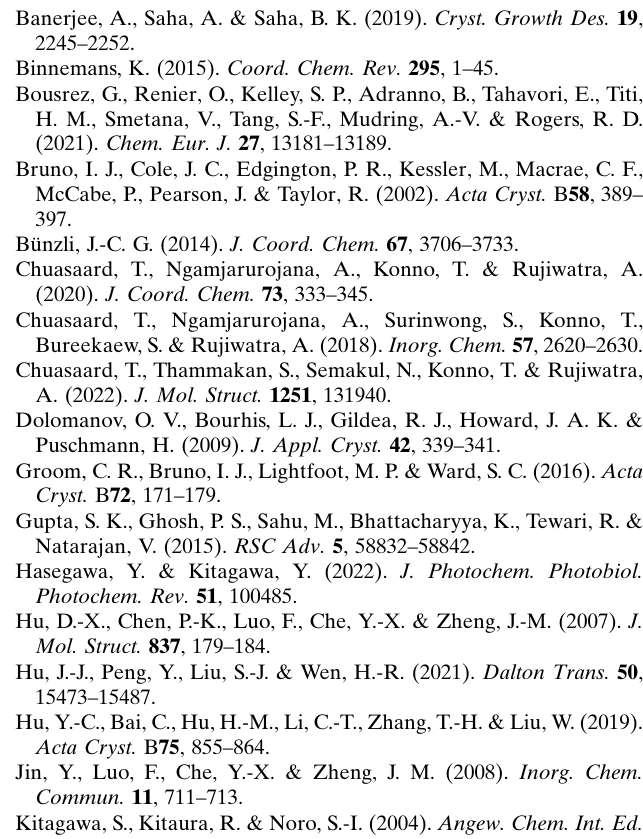
Table 3 Experimental details. Crystal data Chemical